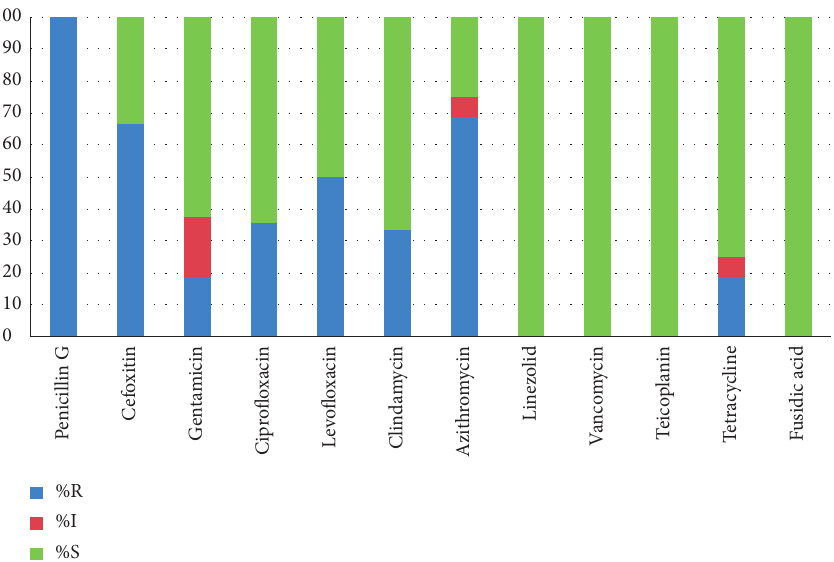
Figure 3: Sensitivity to antibiotics S. epidermidis from